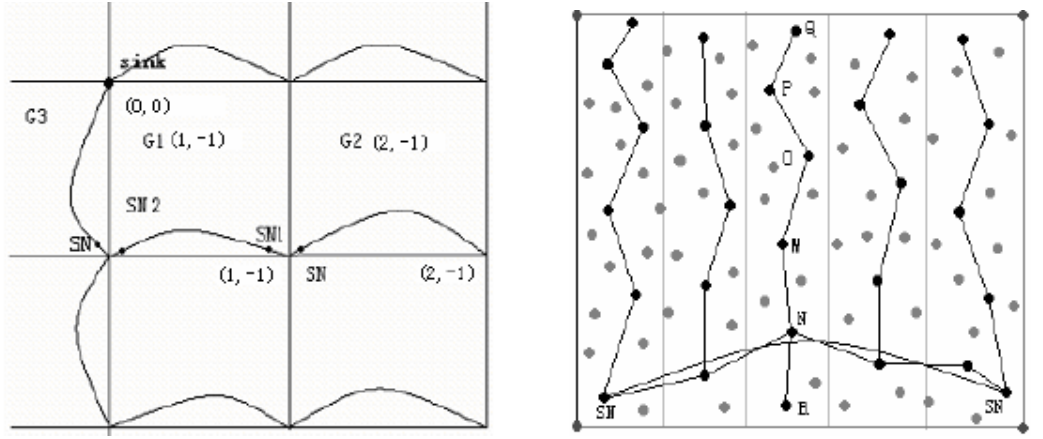
Figure 21. The constructed grid by sink [50]. Figure 22. Single grid with path